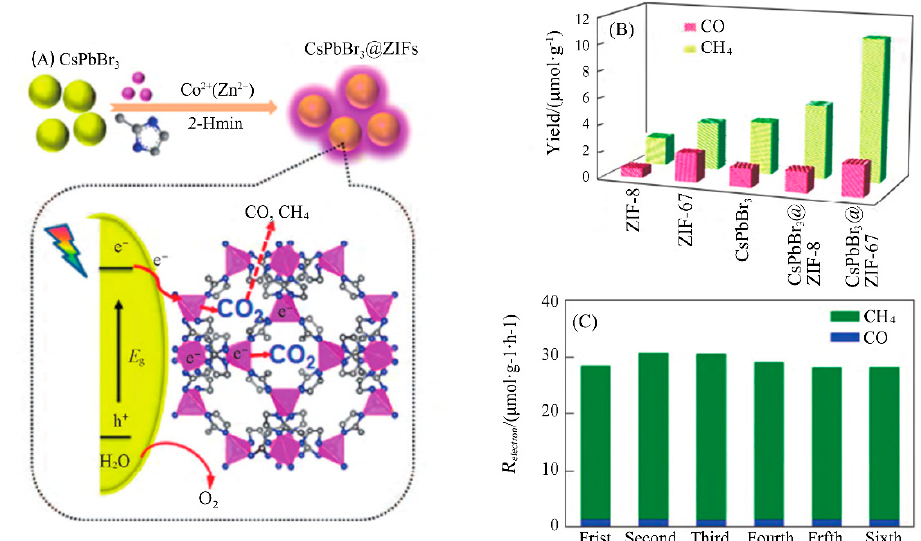
Figure 6. Schematic illustration of the fabrication process and CO 2 photoreduction process of CsPbBr 3 / ZIFs ( A ) and photocatalytic CO 2 reduction performances of CsPbBr 3 and CsPbBr 3 @ZIFs ( B , C ). Reprinted from ref. 94 with permission by the American Chemical Society.